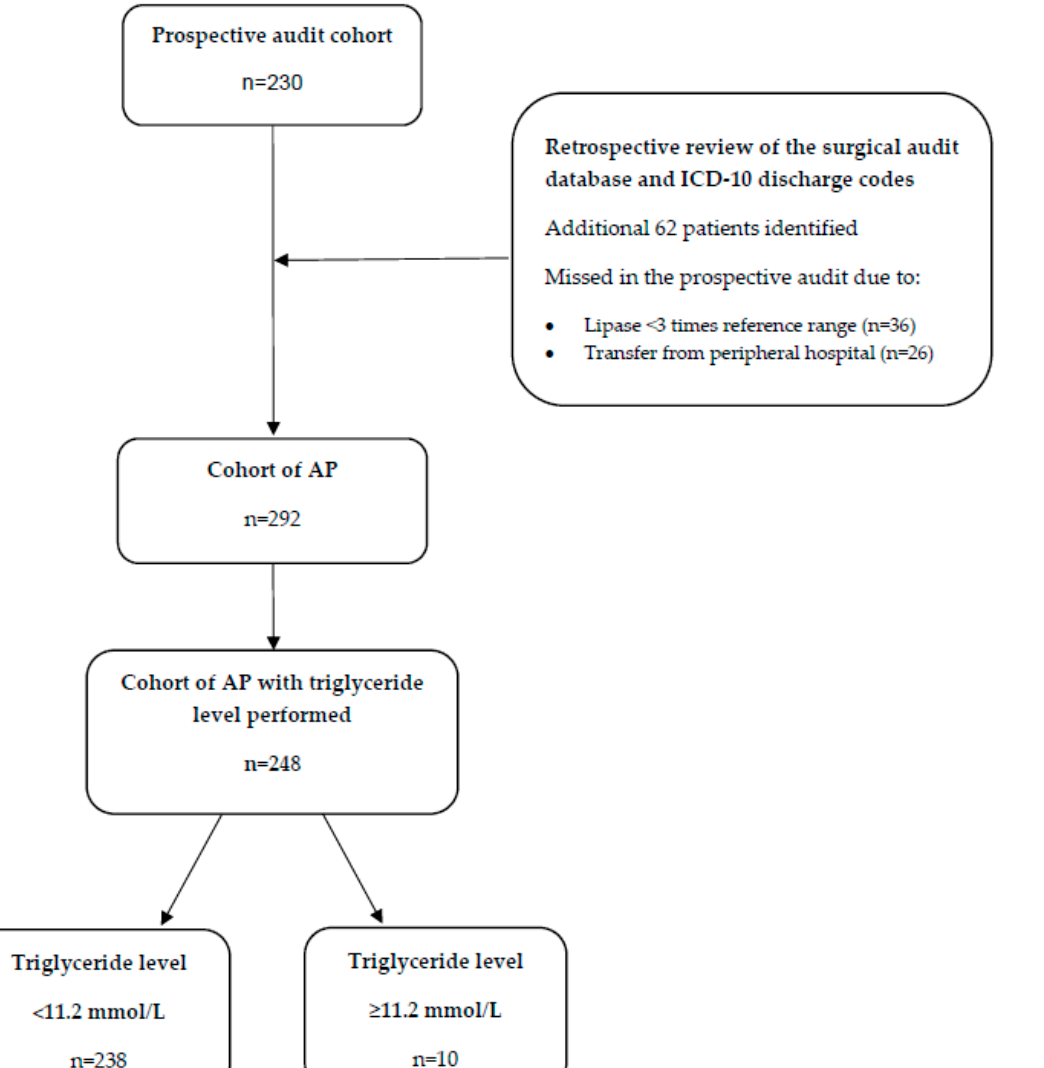
Figure 1. Participant flow chart. AP: acute pancreatitis. Table 1. Demographic and clinical data comparing hypertriglyceridemia-associated acute pancreatitis (HTGAP) and non-HTGAP groups.